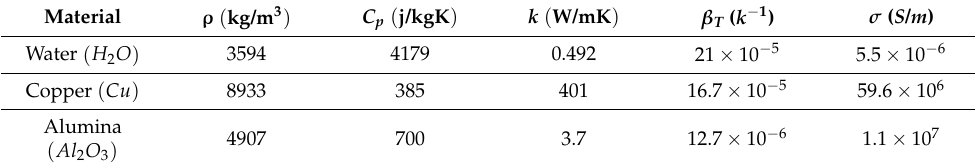
Table 1. The Experimental values of Copper, Aluminium Oxide, and Water [34].